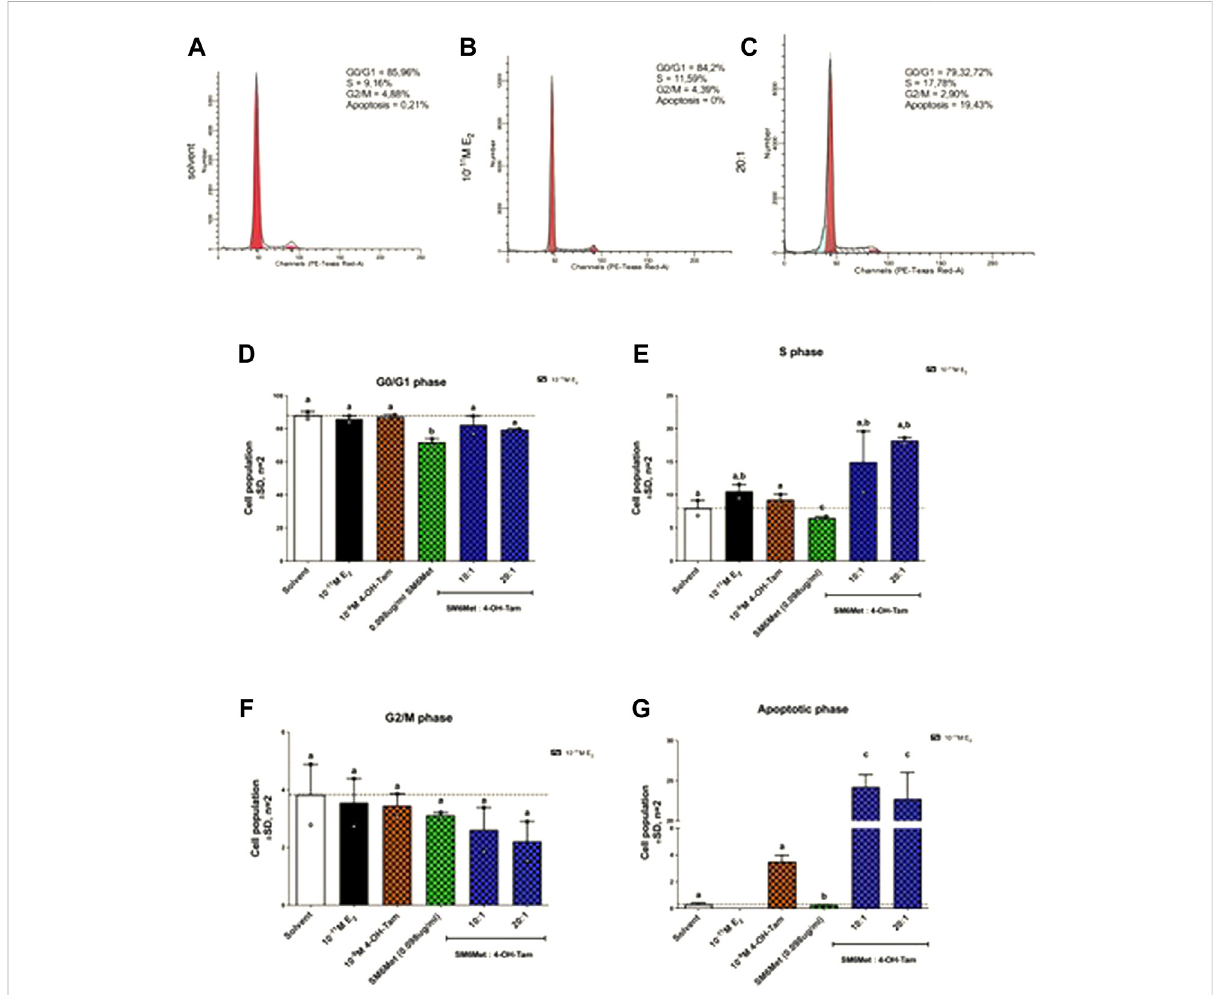
The average effect of 4-OH-Tam (10 − 9 M), SM6Met (0.098 μ g/ml), and combinations of SM6Met with 4-OH-Tam in ratios of 10:1 and 20:1, in the presenceof10 − 11